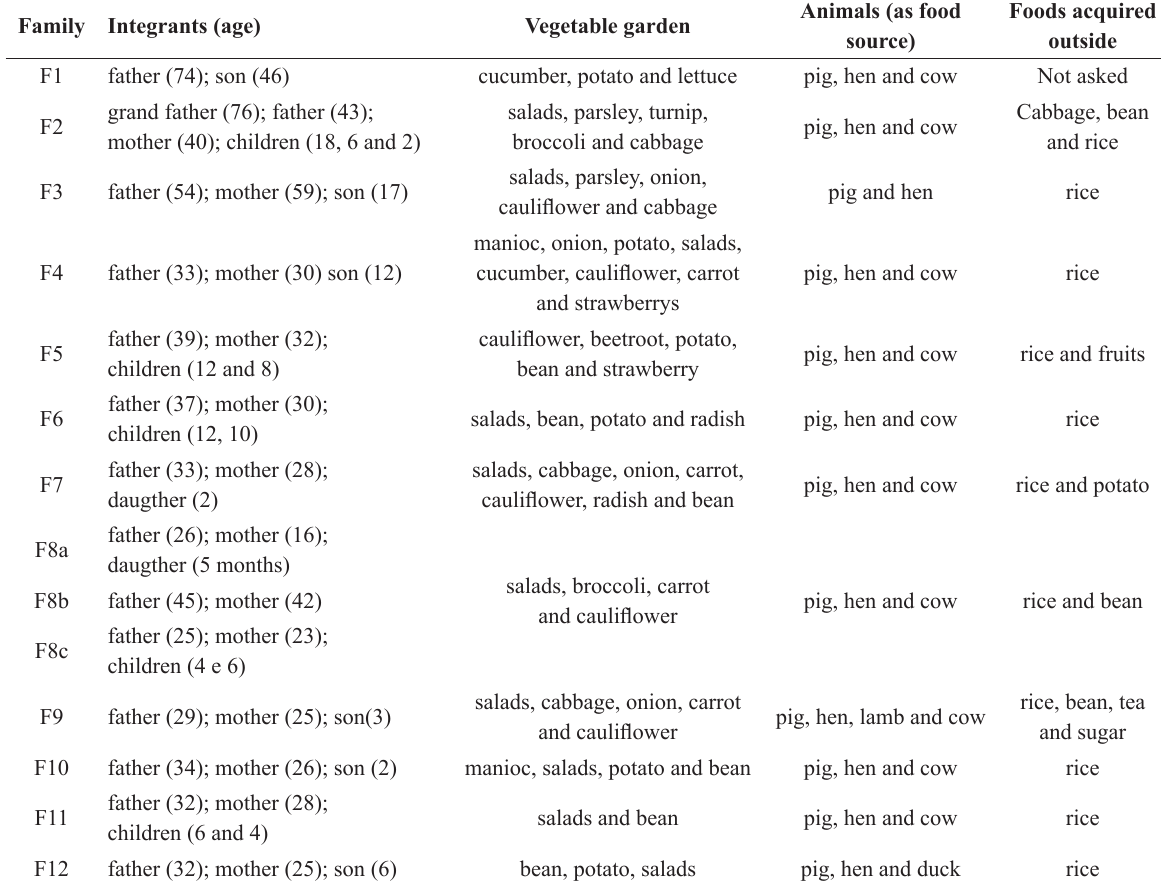
Families’ characteristics selected for the second